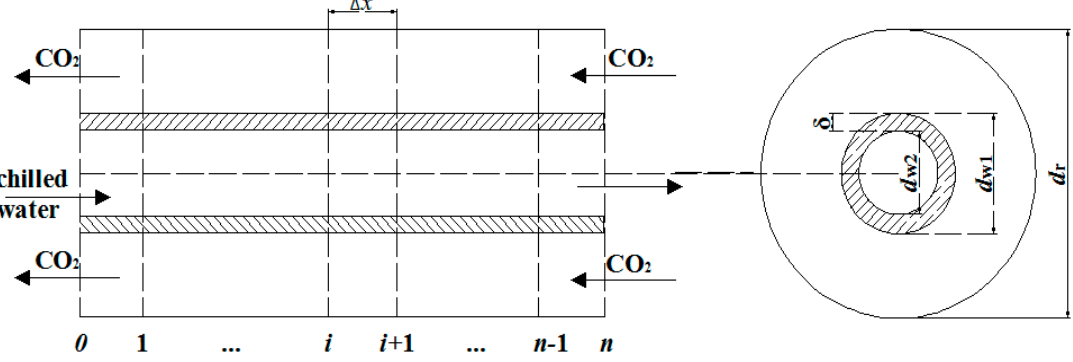
Figure 8. CO 2 double-pipe evaporator model.